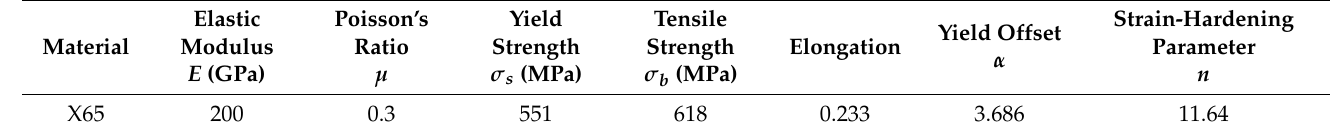
Table 2. X65 mechanical parameters of X65 pipeline steel.